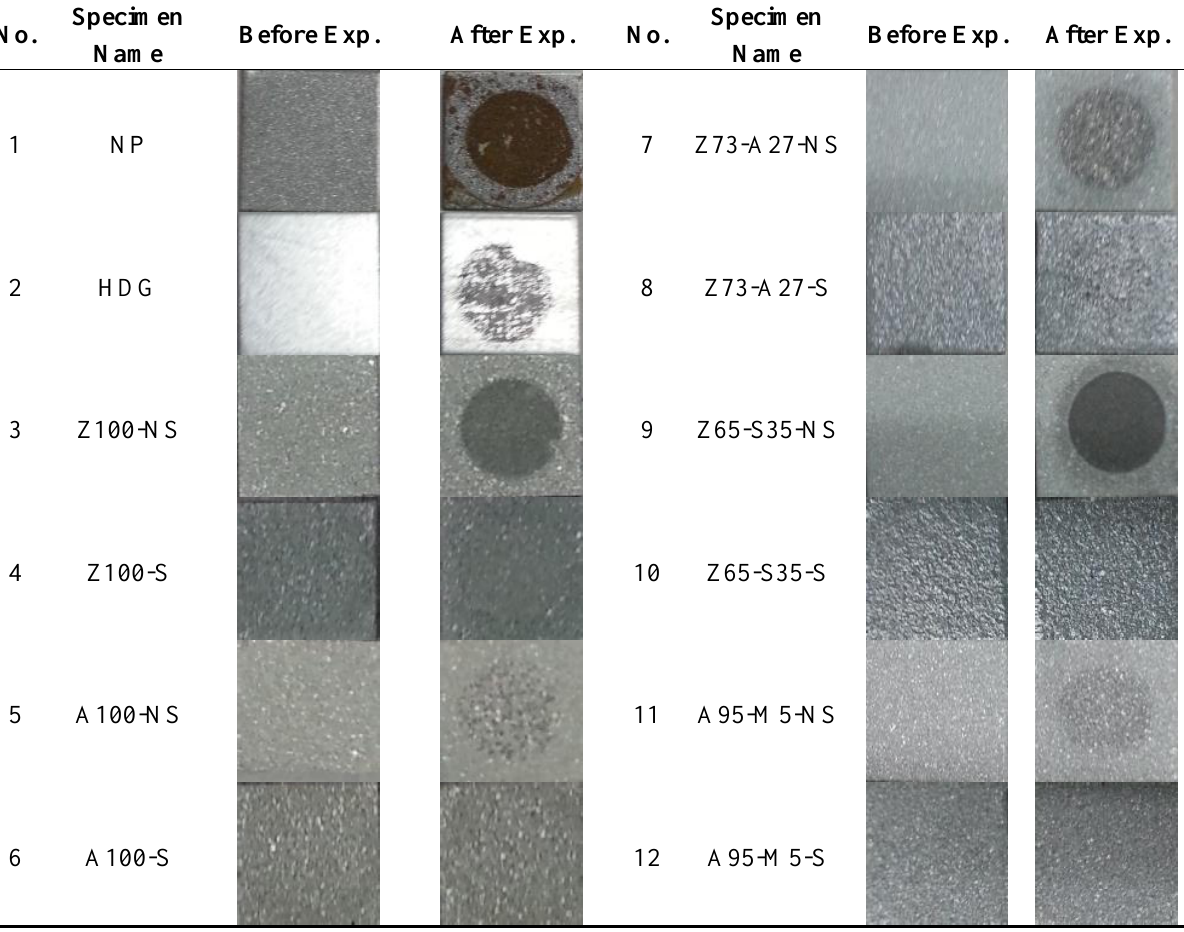
Table 4. Surface conditions of the specimens before and after carrying out the electrochemical